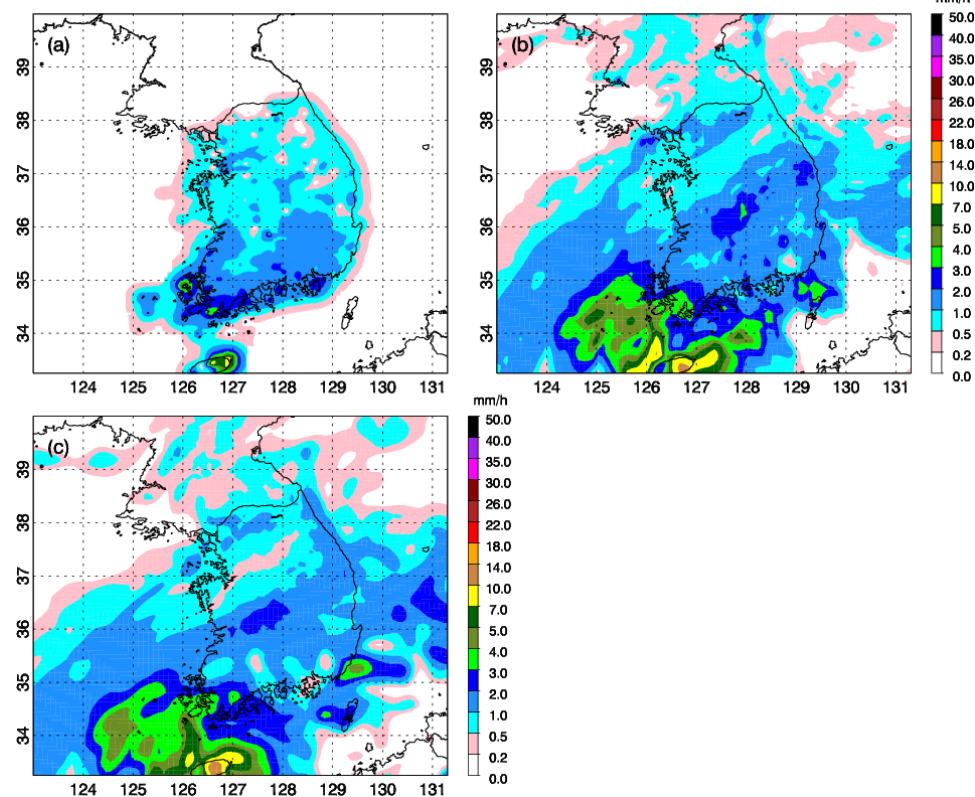
Figure 9. 1h precipitation (mmh − 1 ) from (a) South Korean Surface Analysis, (b) CTRL_Mar, and (c) DA_Mar at 16:00UTC 7 March